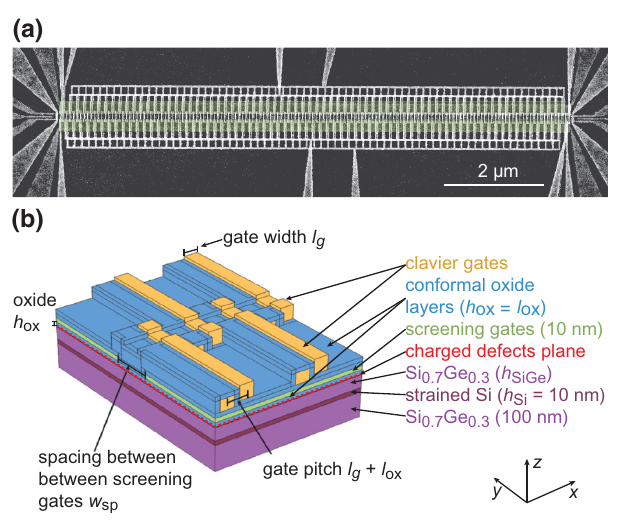
FIG. 5. Realistic Si/SiGe SQS device. (a) Scanning electron micrograph of 10- µ m-long SQS showing three gate layers: on top of a screening gate layer (colored in green), two clavier gate layers connected to four gate sets for CB mode. Gates at the ends of the SQS are for the formation of single-electron transistors. (b) COMSOL model of the SQS device from (a) showing two SQS unit cells and thus eight clavier gates. The typical thickness of layers is given in brackets.